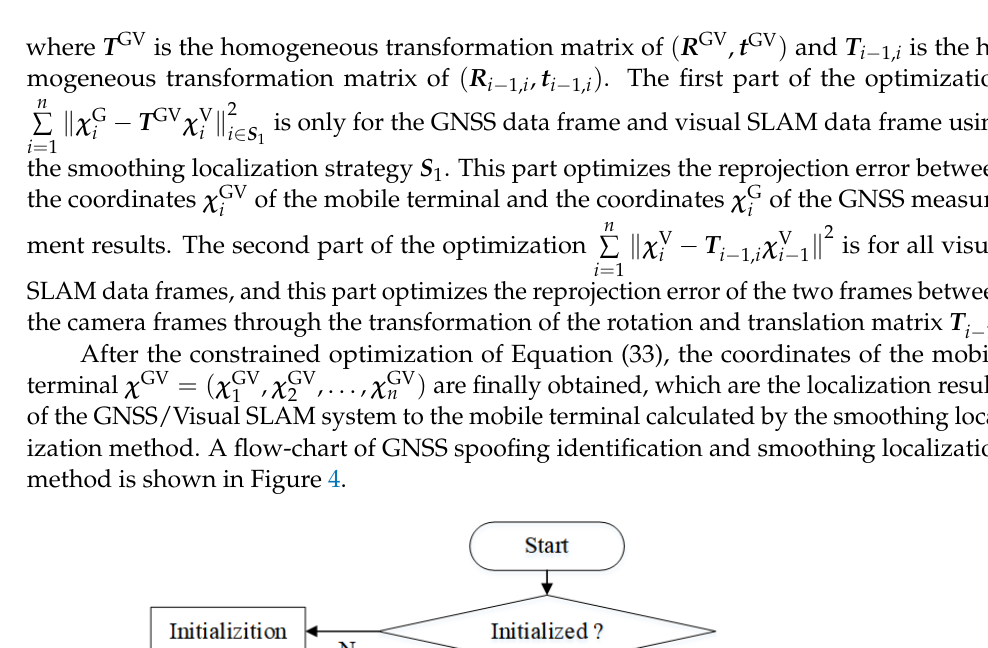
( b ) Figure 5. Trajectories of ground-truth in ( a ) rural and ( b ) urban scenes.